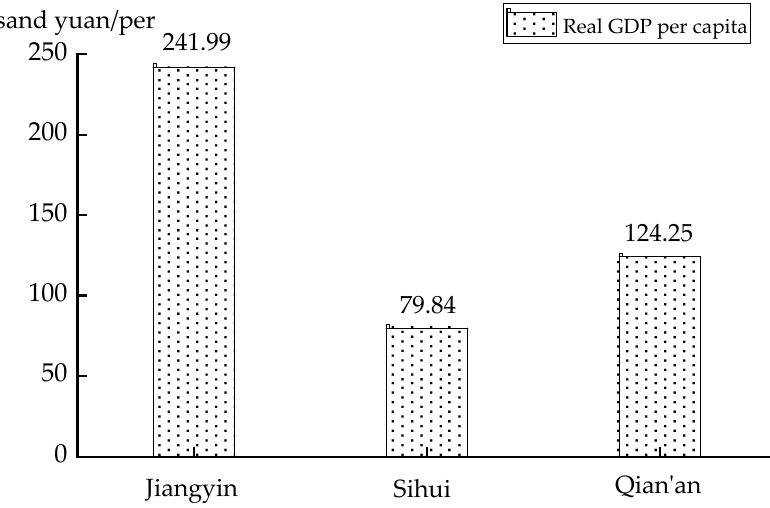
Figure 9. Per capita GDP of counties.